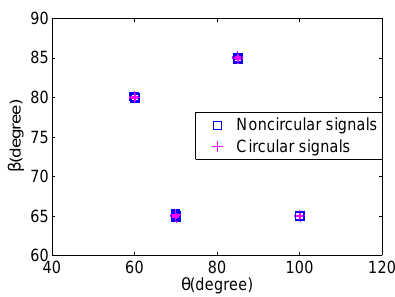
Figure 2. The 2D direction-of-arrival estimation scattergram of the two-stage rank reduction (TSRARE) method.